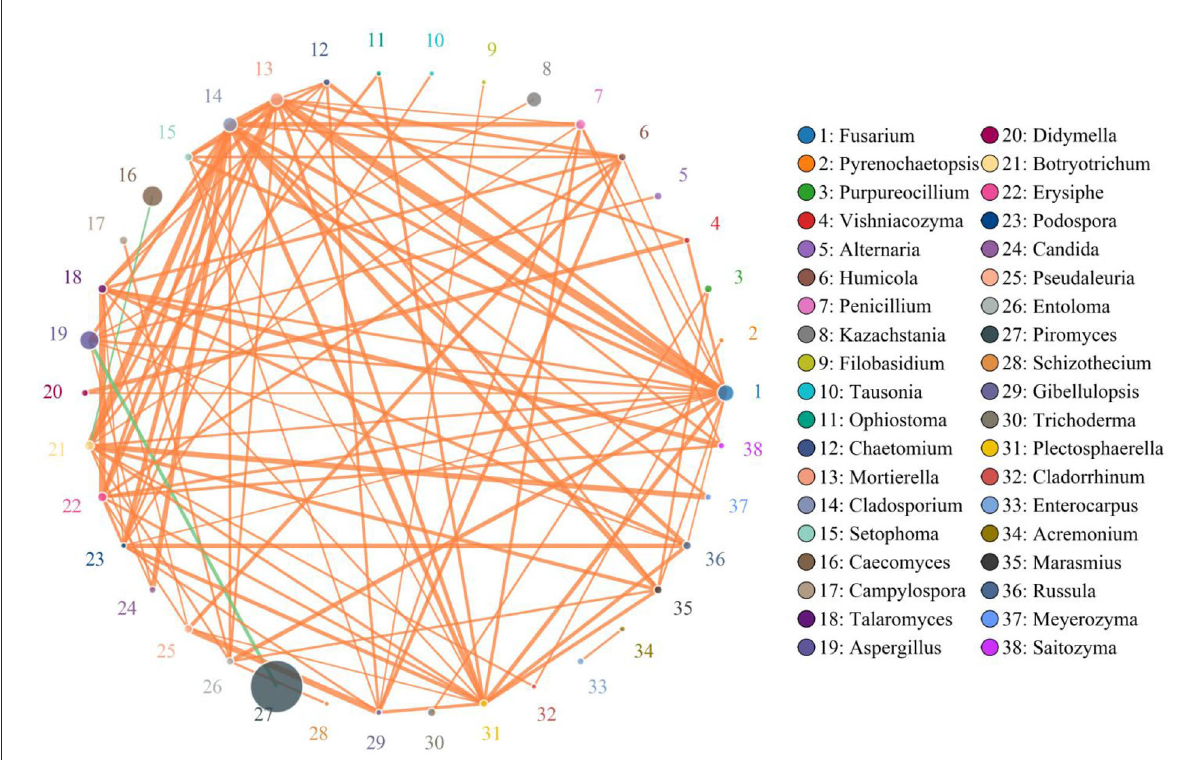
FIGURE6 Correlation network analysis of gut fungal diversity. The correlation between fungi is represented by lines of different colors. The orange lines represent the positive correlation, whereas the green lines represent negative correlation. Detailed data were shown in the